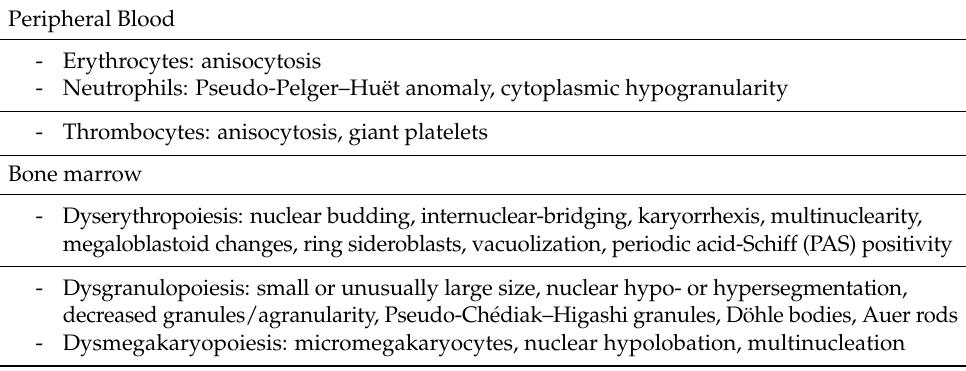
Table 5. Morphological characteristics of dysplasia